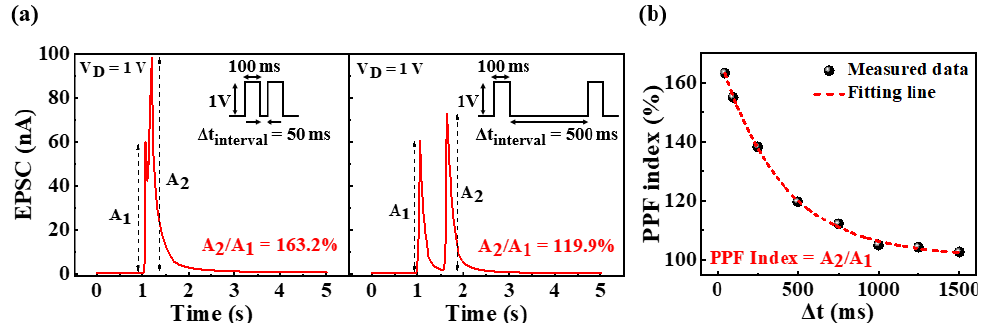
Figure 4. ( a ) Paired pulse facilitated EPSCs by two consecutive pre-synaptic spikes (1 V, 100 ms) at ∆ t interval = 50 ms and ∆ t interval = 500 ms and ( b ) paired-pulse facilitation (PPF) indices (A 2/ A 1 ) plotted against pre-synaptic spike time interval ( ∆ t interval ) from 50 to 1500 ms.